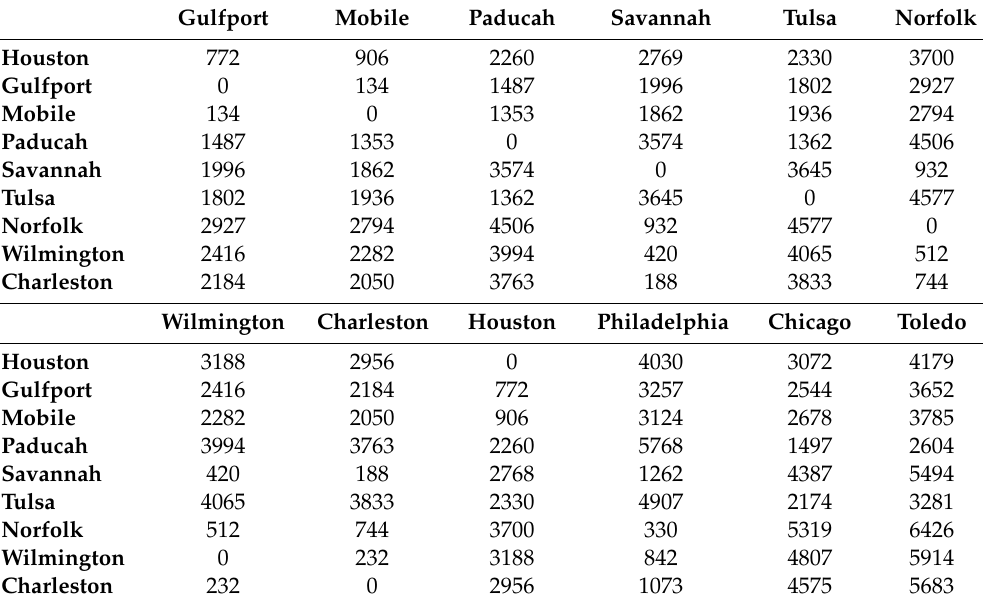
Table A9. Barge distances between Port and Extraction locations (km).